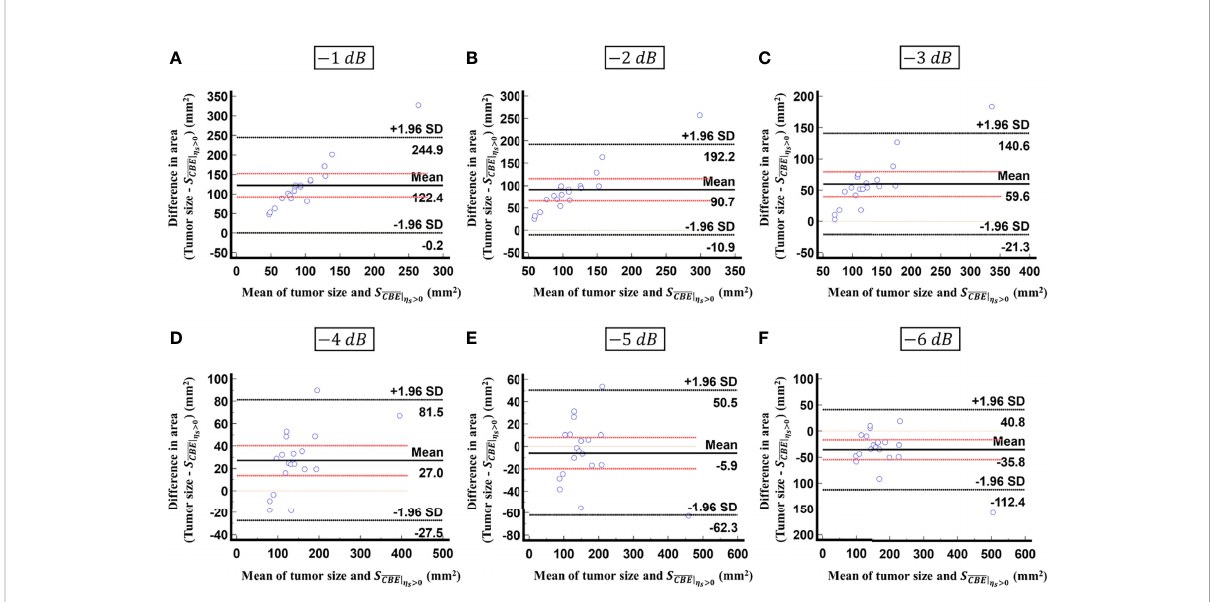
FIGURE 8 Bland-Altman plots of the differences between the tumor sizes and S CBE j values against the averages of the two sets of measurements h s> 0 obtained according to various contour criteria. (A) − 1 dB; (B) − 2 dB; (C) − 3 dB; (D) − 4 dB; (E) − 5 dB; (F) − 6 dB. The red lines represent the 95% CI of the mean difference. The black lines mean the limits of agreement. About 95% of the data points fell within the limits of agreement; in particular, 58% of the data fell within the 95% CI when the contour criteria of − 6 dB was used.